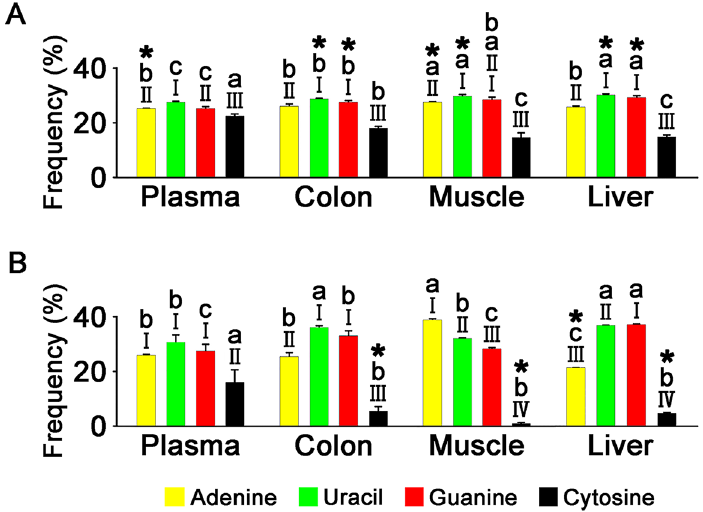
Fig 4. Overall nucleotide composition of miRNAs in different tissues, as assessed by miRNA expression-unweighted (A) and -weighted criteria (B). Different Roman numerals (I, II, III, and IV) above the bars represent significant differences between occurrence frequencies of nucleotides within the tissue, and different alphabetical letters (a, b, and c) represent the significant difference between occurrence frequencies of a nucleotide among the different tissues (n = 3 – 4, one-way ANOVA with Tukey ’ s post hoc test, P < 0.05). * indicates that the occurrence frequency of a nucleotide is smaller in the expression-unweighted criterion than -weighted counterpart within the tissue, or vice versa (Student ’ s t -test, P <